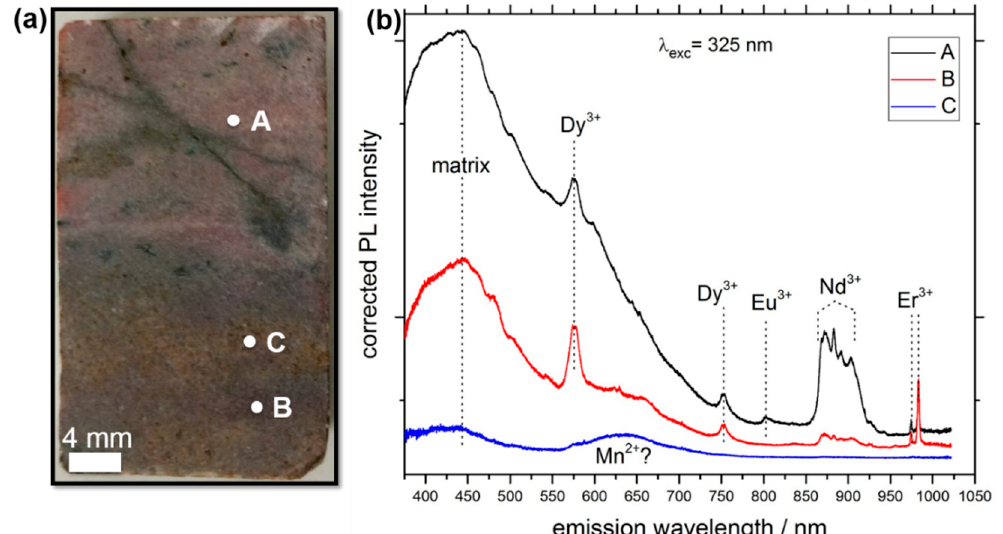
Figure 3. ( a ) RGB image of Lofdal sample marked with three points (spots A, B, and C). ( b ) Focused LIF spectra acquired at the three marked spots. They exhibit different shapes and varying relative intensities of individual peaks (right), which can be attributed to individual REE 3+ ions. The excitation wavelength of the laser was 325 nm (UV). Note the logarithmic ordinate and the offset for the individual curves for clarity.